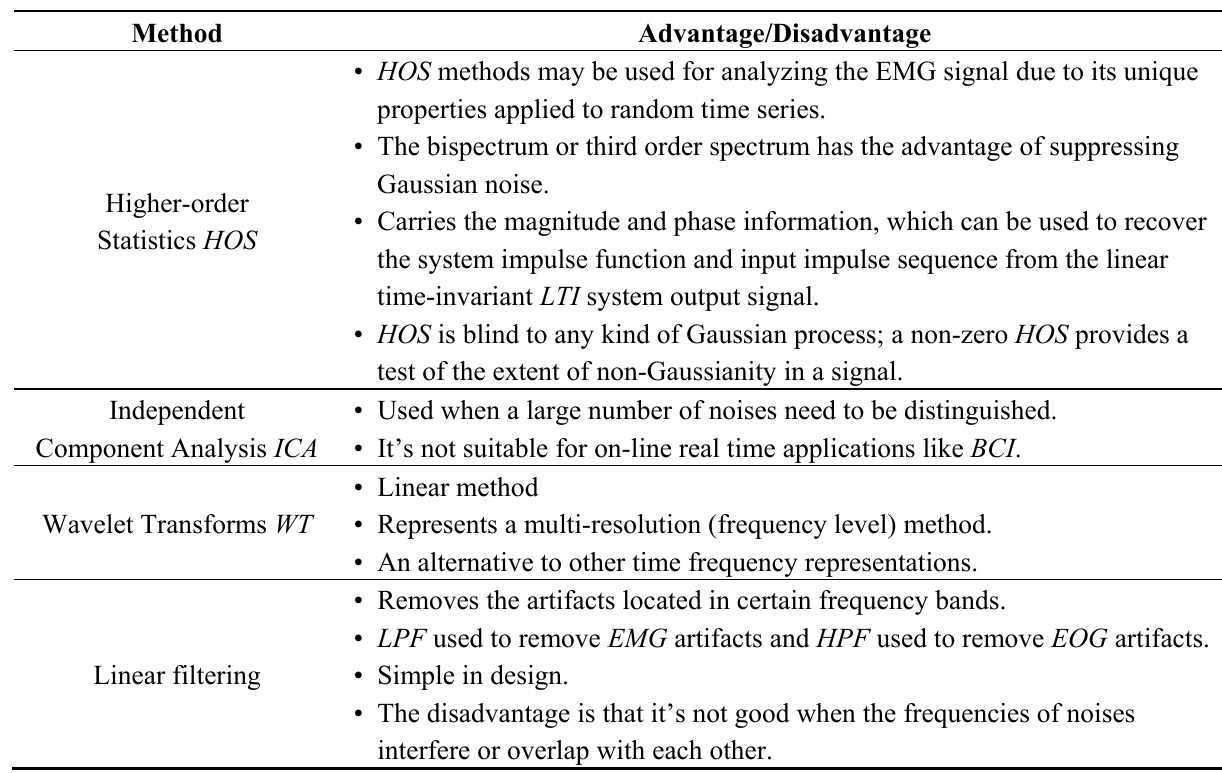
Table 5. The advantages and disadvantages of artifact removal